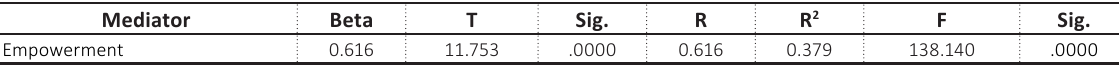
Table 10. Relationship between empowerment and achievements